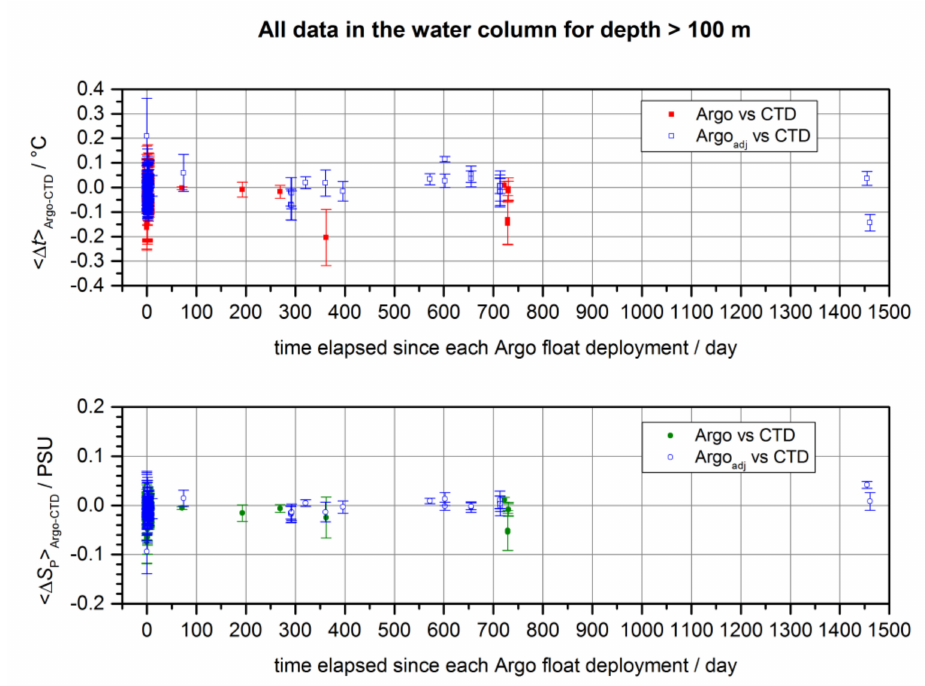
Figure 20. Argo (not-adjusted and adjusted) vs. CTD: temperature ( top ) and practical salinity ( bottom ) mean di ff erences (indicated by symbols < > ) under 100 m plotted vs. time elapsed since Argo